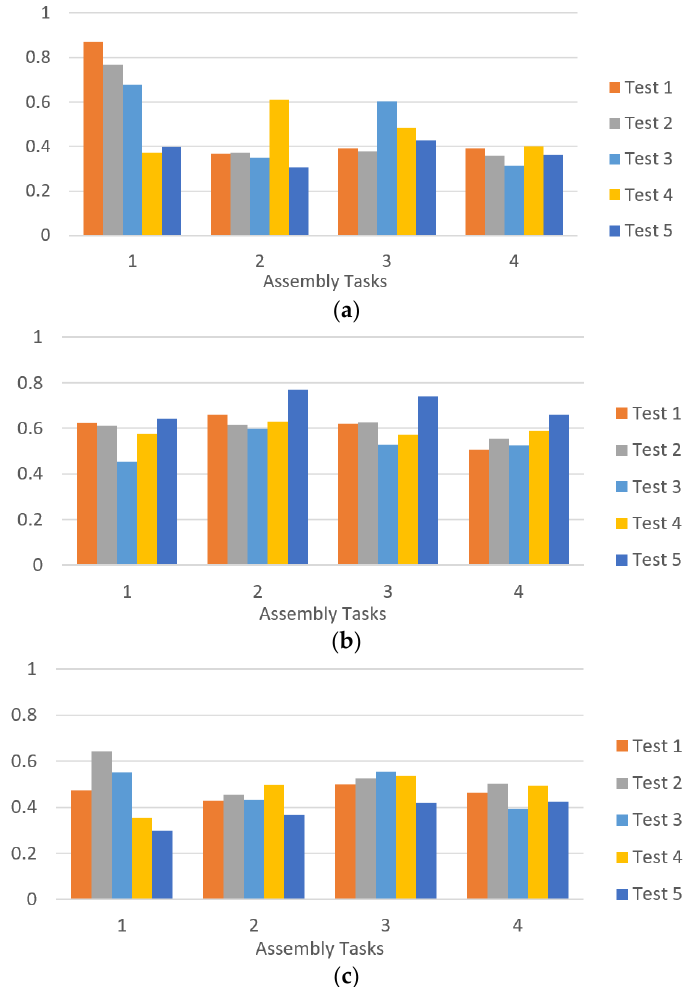
Figure 11. Emotion’s level of the human worker during the 5 tests: ( a ) stress level; ( b ) engagement level; ( c ) focus level.